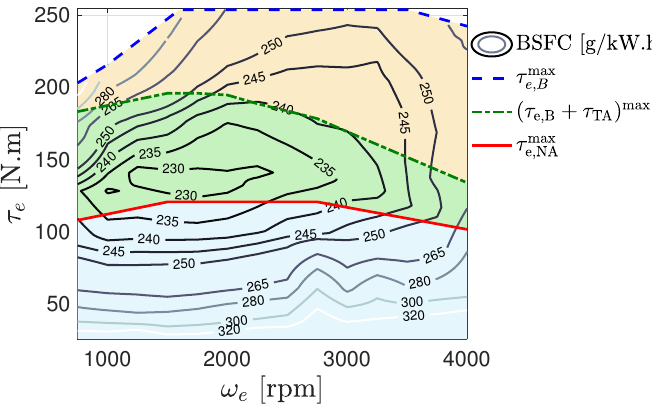
Figure 4. Brake specific fuel consumption (BSFC) map for the engine with the power split supercharger (PSS). The naturally aspirated engine maximum torque, τ max torque assist mode, ( τ e ,NA + τ TA ) max , and the maximum engine torque during boosting mode, τ max are also